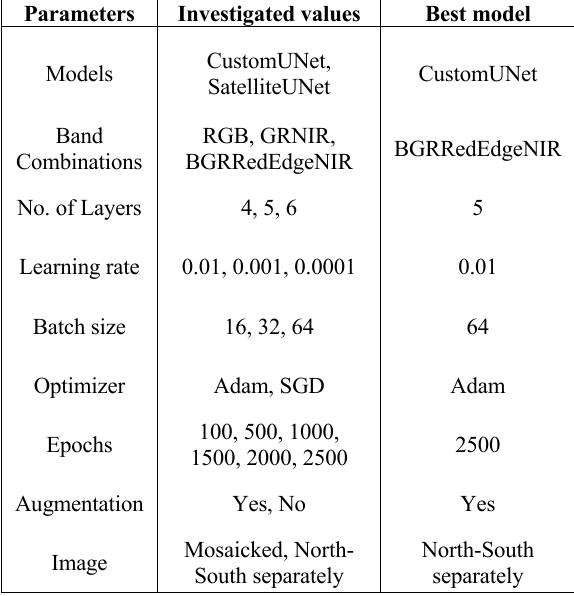
Table 1: Investigated Hyperparameters